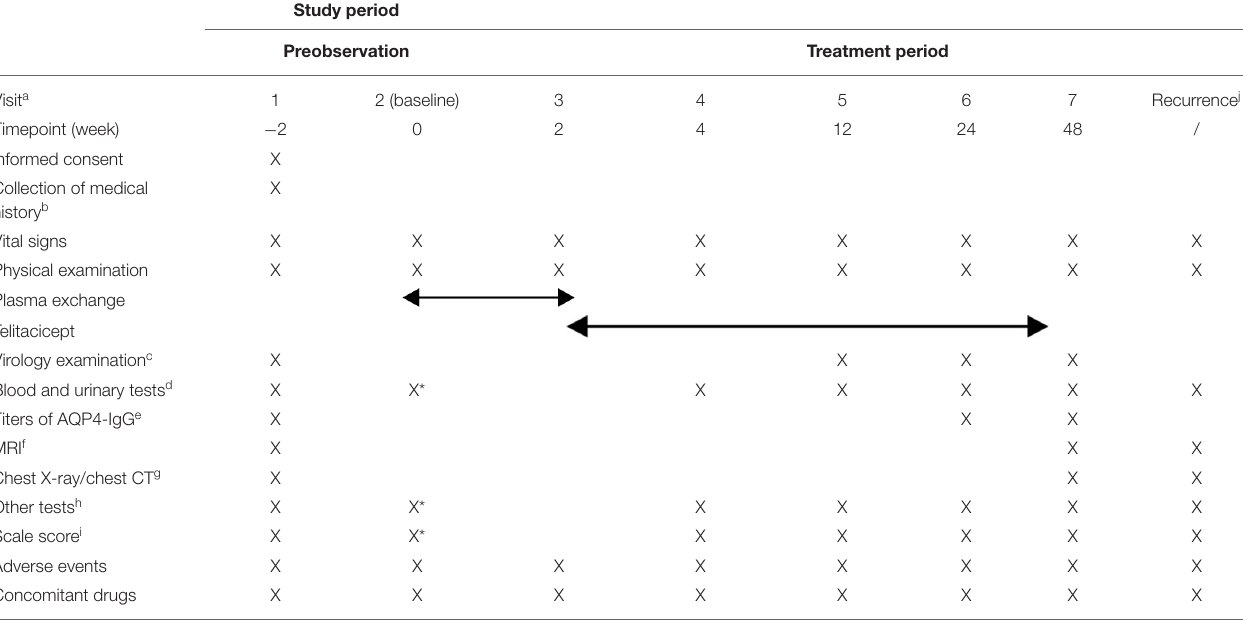
TABLE 1 | Schedule of enrollment, interventions and assessments. Study